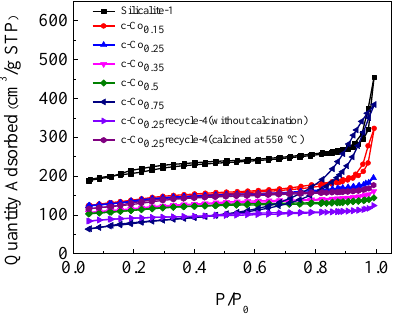
Figure 2. N 2 adsorption – desorption isotherms of pristine silicalite-1 and c-Co x . Table 1. Textural properties of silicalite-1 and c-Co x.